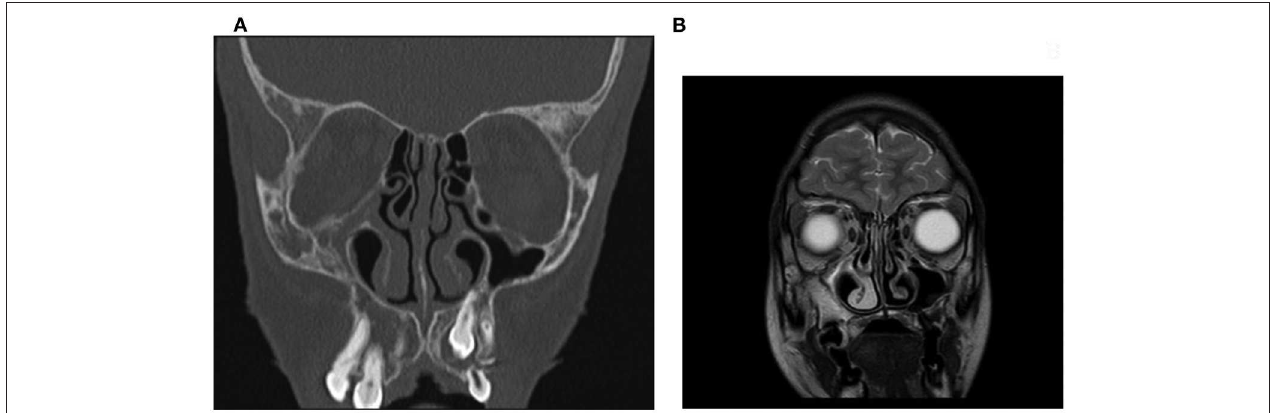
FIGURE 3 | Facial MRI (A) and CT (B) scans performed in the patient with WS when she was 7 years old. MRI showed that the right maxillary sinus was opacified, with central inspissated secretions; it was also diminished in volume with inward bowing of the maxillary walls and the uncinate process was lateralized (A) . CT scan confirmed the opacified right maxillary sinus with retraction of the maxillary walls as well as the lateralized and demineralized uncinate; it also demonstrated the partial occlusion of the maxillary infundibulum and the fact that the orbital floor was located inferiorly.